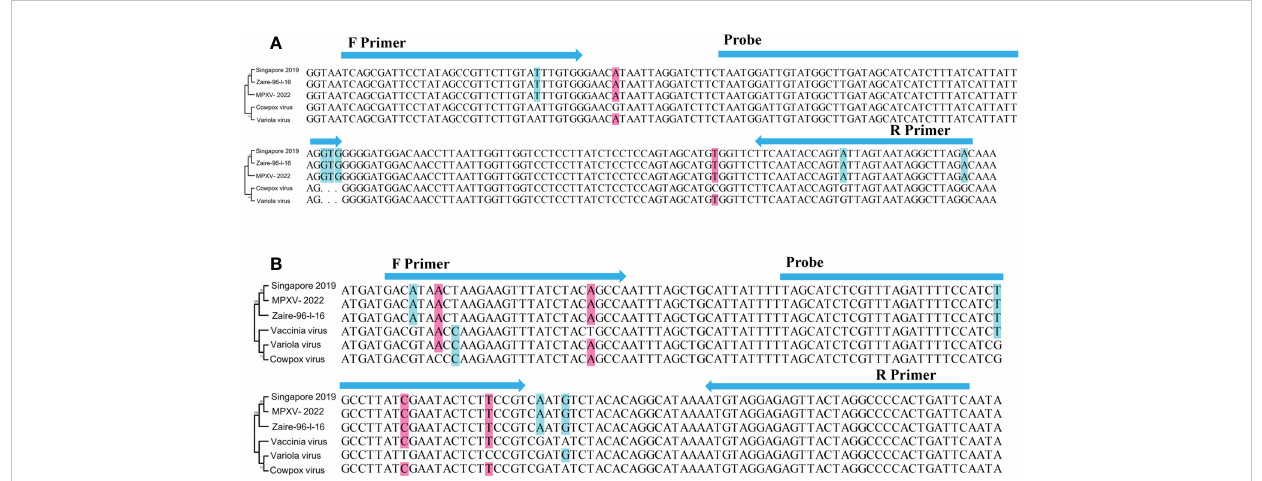
FIGURE 1 Schematic diagram of the relative position of primers and probes. (A) A27L gene and (B) F3L gene. Singapore 2019(GenBank: MT250197.1), Zaire-96- I-16(GenBank: AF380138.1), Variola virus(GenBank: LR800245.1), Cowpox virus(GenBank: MK035759.1); Vaccinia virus(GenBank: MK314713.1). Phylogenetic trees were constructed by MEGA 7 (Kumar et al., 2016), using the maximum likelihood method,based on A27L gene and F3L gene,